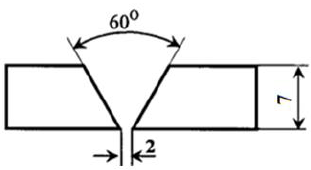
Figure 1. Preparation of the edges of experimental J55 steel samples.